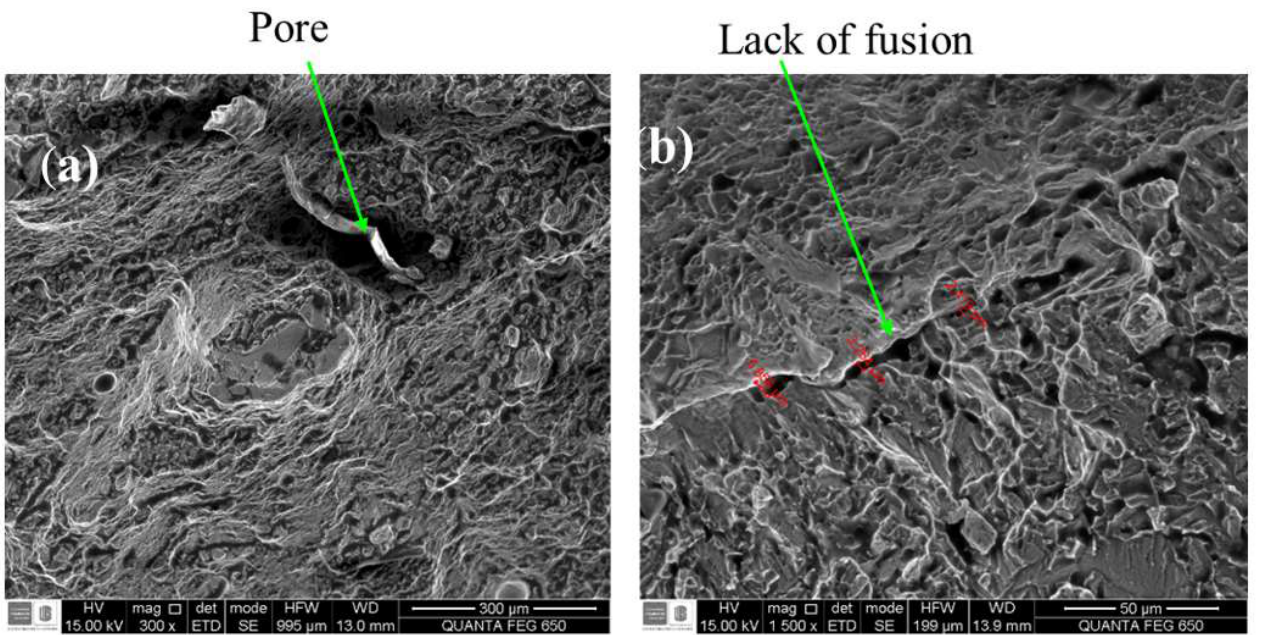
Figure 12. Fracture surface showing: ( a ) porosity defects; ( b ) lack of